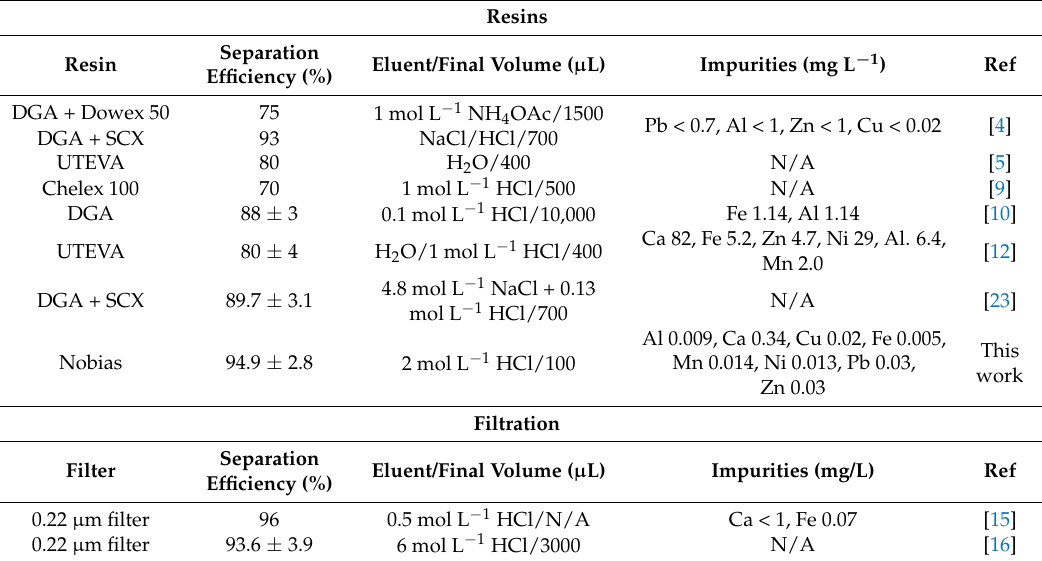
Table 1. Comparison of the methods used for separation of scandium radioisotopes from calcium carbonate